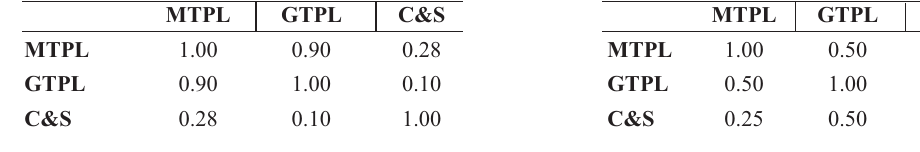
Fig. 5. Correlation matrix and comparison with the default model.